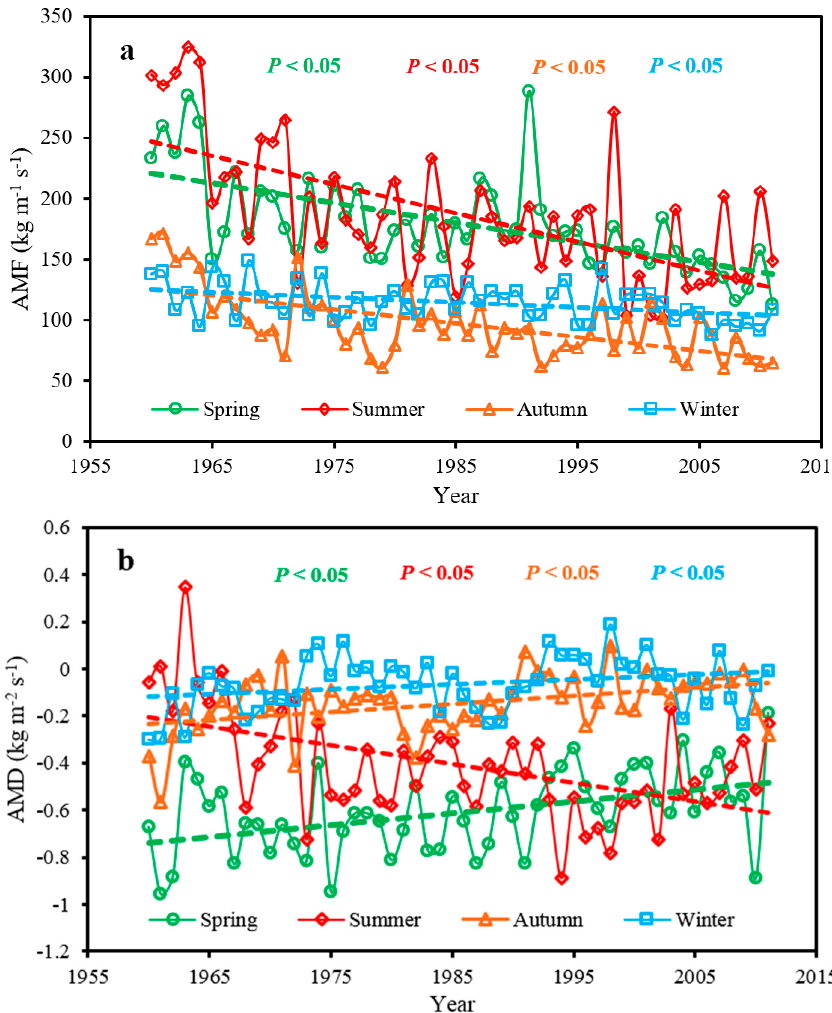
Figure 6. Changing patterns of the ( a ) atmospheric moisture flux (AMF) and ( b ) atmospheric moisture divergence (AMD) in varying seasons in Dongting Lake Basin.